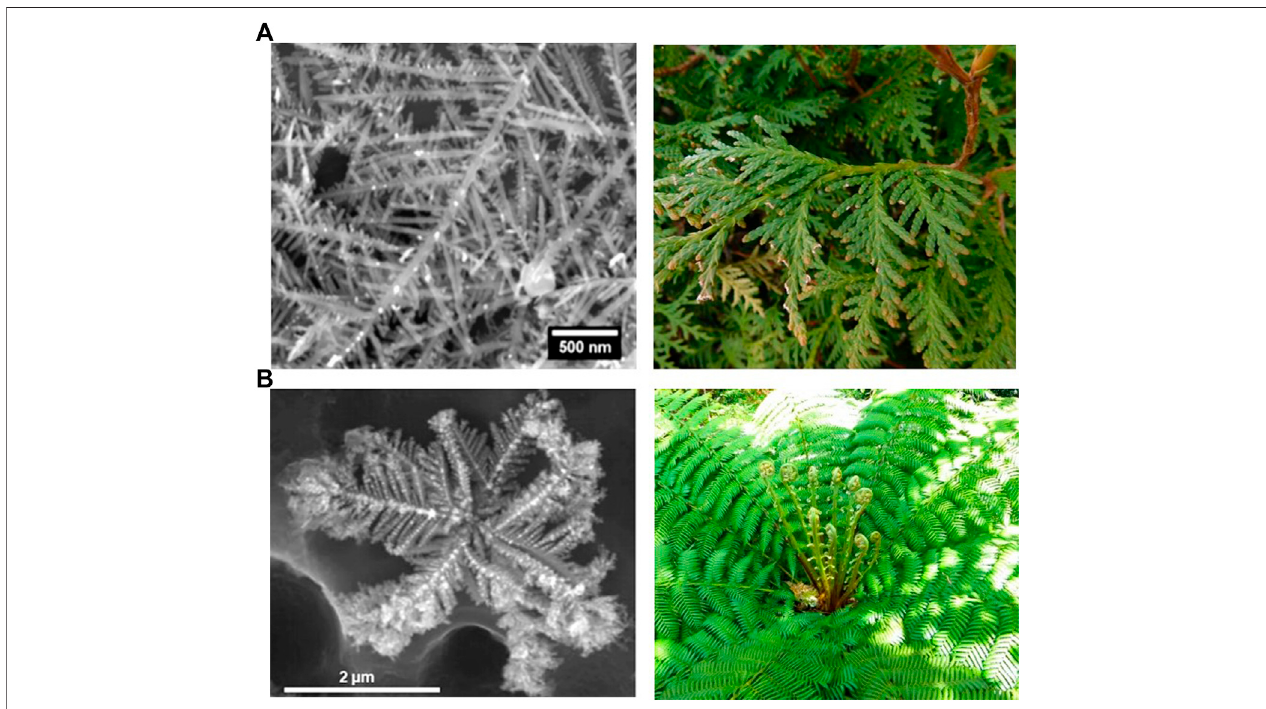
FIGURE 8 | (A) FE-SEM micrograph of silver nanodendrites electrodeposited on aluminum [Reprinted from Mater. Chem. Phys. 240 (2020) 122225. Copyright (2020), with permission from Elsevier] compared with the photograph of leaves of the conifer Tuya (Thuja occidentalis) (Pixabay license for the public domain. Available on: https://pixabay.com/sv/photos/thuja-cypressv%c3%a4xter-livets-tr%c3%a4d-1571074/). (B) SEM micrograph of Ag-Cu bimetallic nanodendrites (Reprinted from Rubén Darío Rivera-Rangel et al. 2020 Nanotechnology 31 465605. © 2020 IOP Publishing Ltd.) compared to western swordfern (Polystichum munitum) photography (Pixabay license for the public domain. Available on: https://pixabay.com/de/photos/farn-p fl